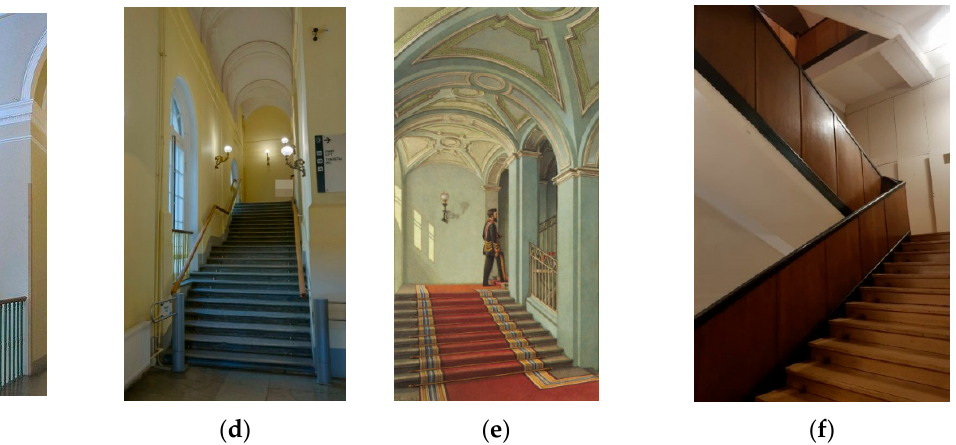
Figure 3. Staircases provided for the evacuation of visitors to the Winter Palace: ( a ) Jordan Staircase; ( b ) Great Church Staircase; ( c ) October Staircase; ( d ) Commandant Staircase; ( e ) Saltykov Staircase; ( f ) Wooden Staircase. Photo by the authors.